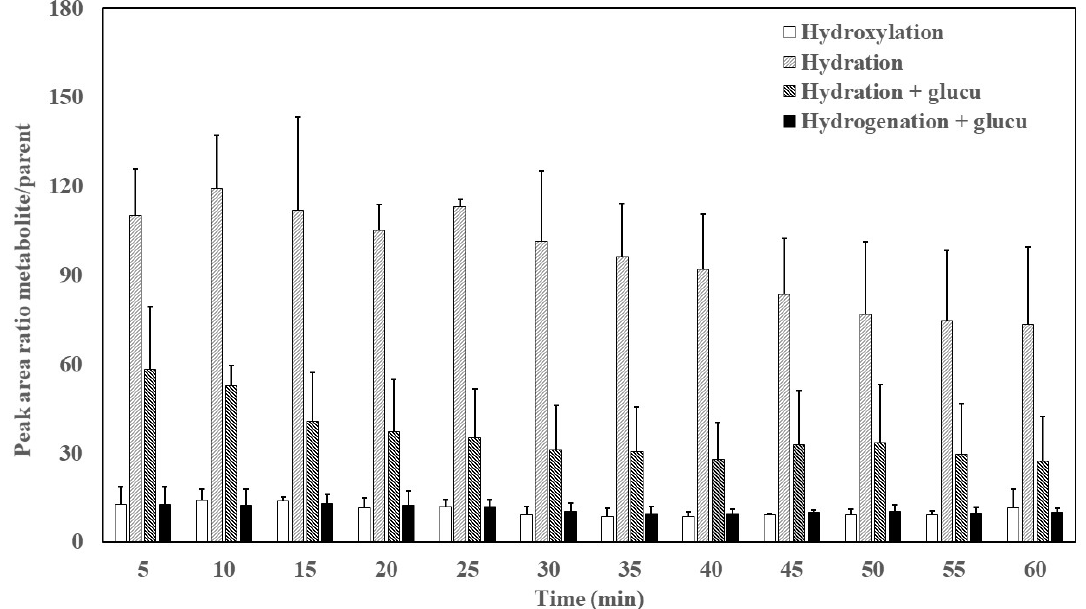
Figure 3. Peak area ratio metabolite / OLC as a function of time in plasma. Results are expressed as the mean ± standard deviation.